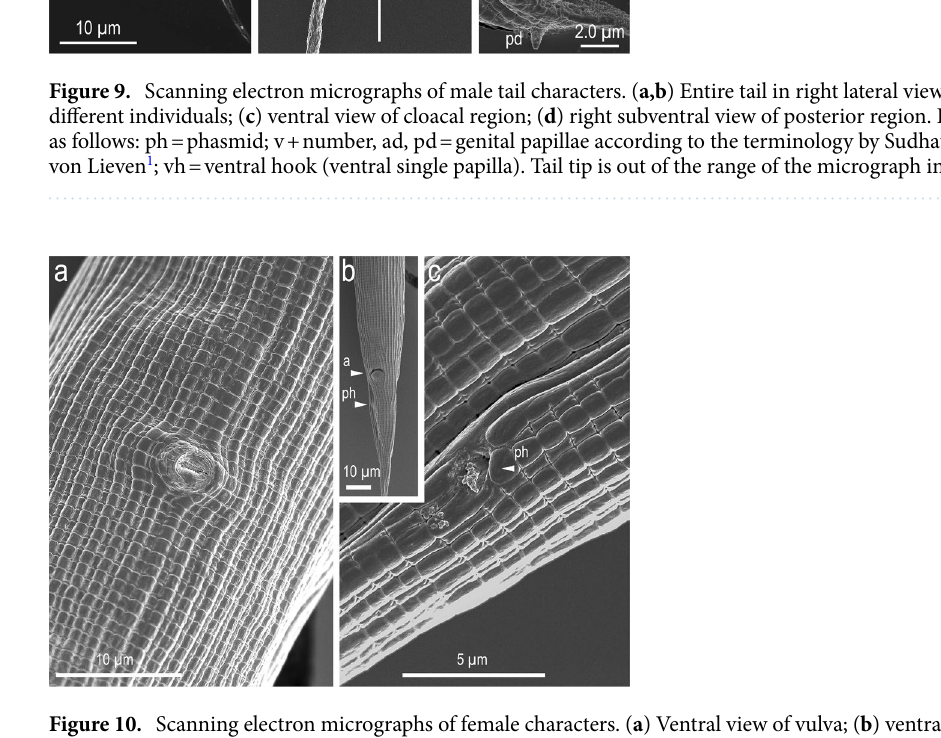
Figure 10. Scanning electron micrographs of female characters. ( a ) Ventral view of vulva; ( b ) ventral view of entire tail; ( c ) right lateral view of phasmid region. Labels are as follows: a = anus; ph =